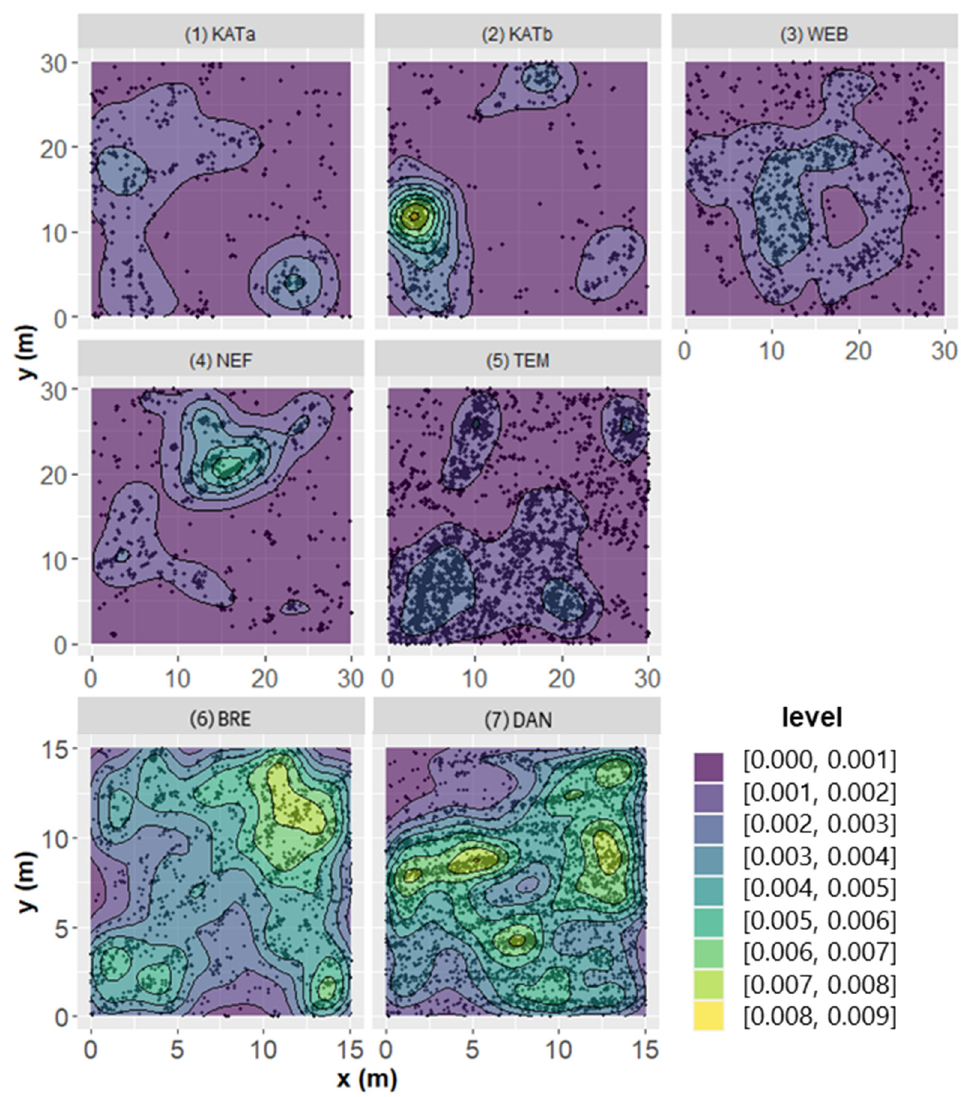
Figure 4. Spatial distribution and densities (level) of pine seedlings on the different sites.